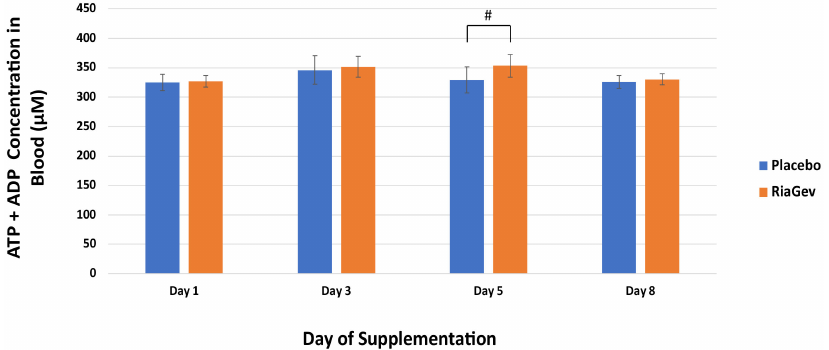
Figure 5. Whole blood ATP and ADP measurements on Days 1, 3, 5, and 8. ATP + ADP concentrations are represented by solid bars with standard errors indicated. Significant difference between the group is marked by # ( p < 0.05).